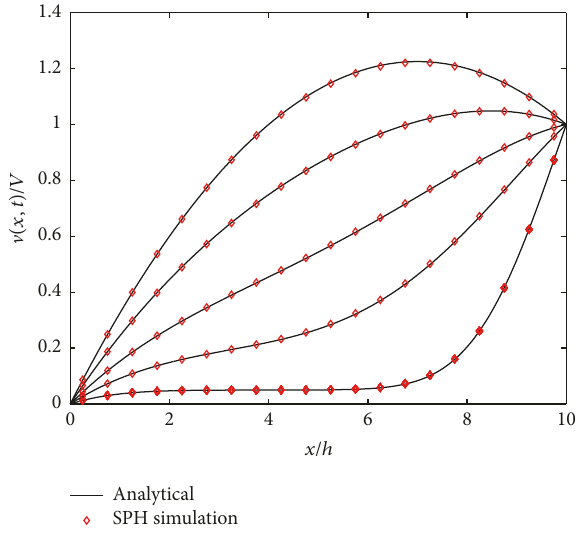
Figure 2: Transient Poiseuille-Couette flow. Velocity profile evo- lution with time. Velocity profiles correspond to 𝑡 = 10 −2 s, 𝑡 = 4 ⋅ 10 −2 s, 𝑡 = 8 ⋅ 10 −2 s, 𝑡 = 16 ⋅ 10 −2 s, and 𝑡 = 1 s.